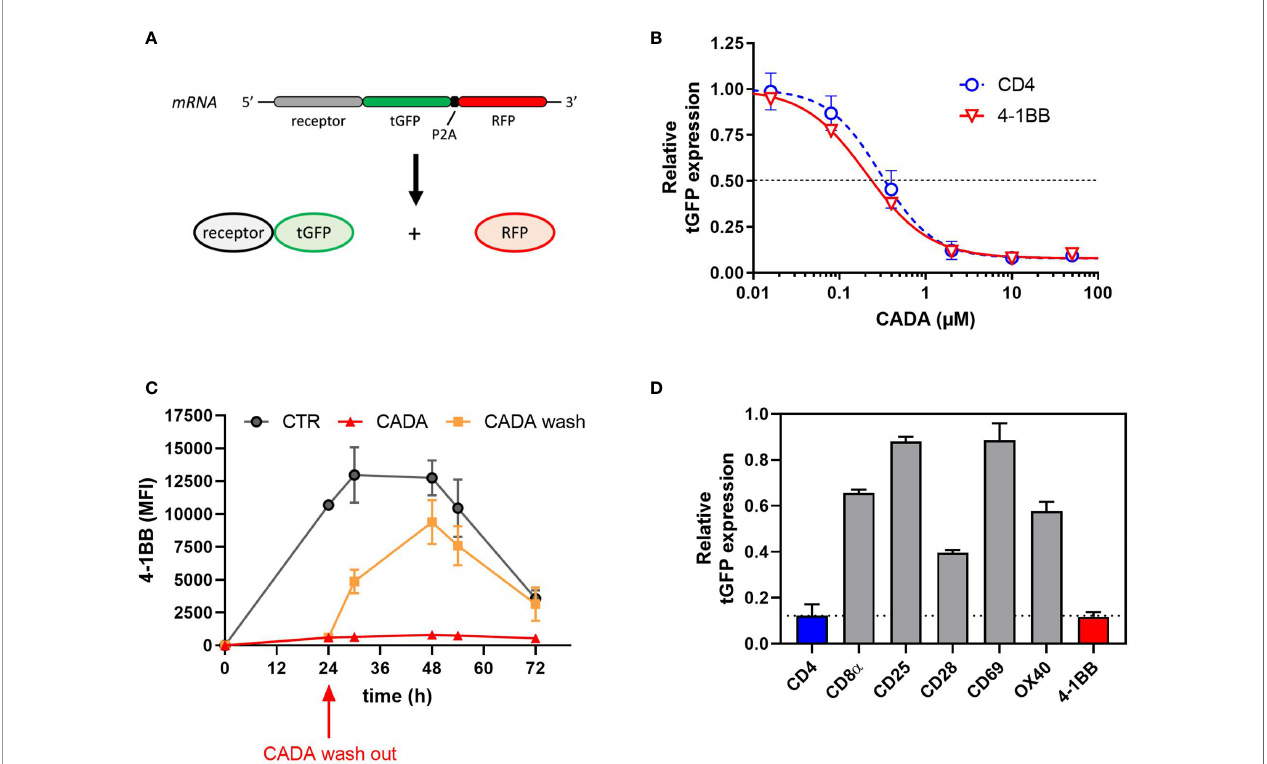
FIGURE 7 | CADA dose-dependently and reversibly suppresses the cellular expression of 4 ‑ 1BB in HEK293T cells. (A) Schematic representation of the expected mRNA and protein products of the tGFP-2A-RFP construct. (B – D) HEK293T cells were transiently transfected with the different constructs. CADA was added 6h post transfection and cellular expression of each receptor was determined by measuring tGFP levels by fl ow cytometry. (B) Four parameter dose-response curves for CADA of human CD4tGFP-2A-RFP and human 4 ‑ 1BBtGFP-2A-RFP. Cells were collected 24h post transfection and tGFP was measured by fl ow cytometry. Receptor levels in CADA-treated samples are normalized to the corresponding DMSO control. Curves are showing mean values ± SD of at least 3 independent experiments (n ≥ 3). (C) Cells were transfected with 4 ‑ 1BBtGFP-2A-RFP and given DMSO (CTR) or treated with CADA for 72h. In parallel, CADA-treatment was terminated after 24h (CADA wash). These cells were washed profoundly and given control medium for the duration of the experiment. At the indicated time points, cells were collected and tGFP was measured by fl ow cytometry. At each time point, the average MFI of tGFP (acquired from at least 10,000 cells per experiment) is shown. Of note is that the SD of the CADA samples (red curve) is too small to be visible on the graph. Curves are representing mean values ± SD of 2 independent experiments (n=2). (D) Cells were collected 24h post transfection and tGFP was measured by fl ow cytometry. Bar diagrams are showing the protein levels in CADA- treated samples, normalized to the corresponding DMSO control (set as 1.0). Values represent mean ± SD of at least three independent experiments (n ≥ 3). See also Supplementary Figure 7